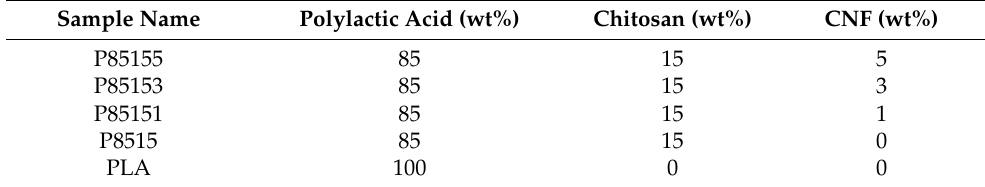
Table 3. Percentage composition